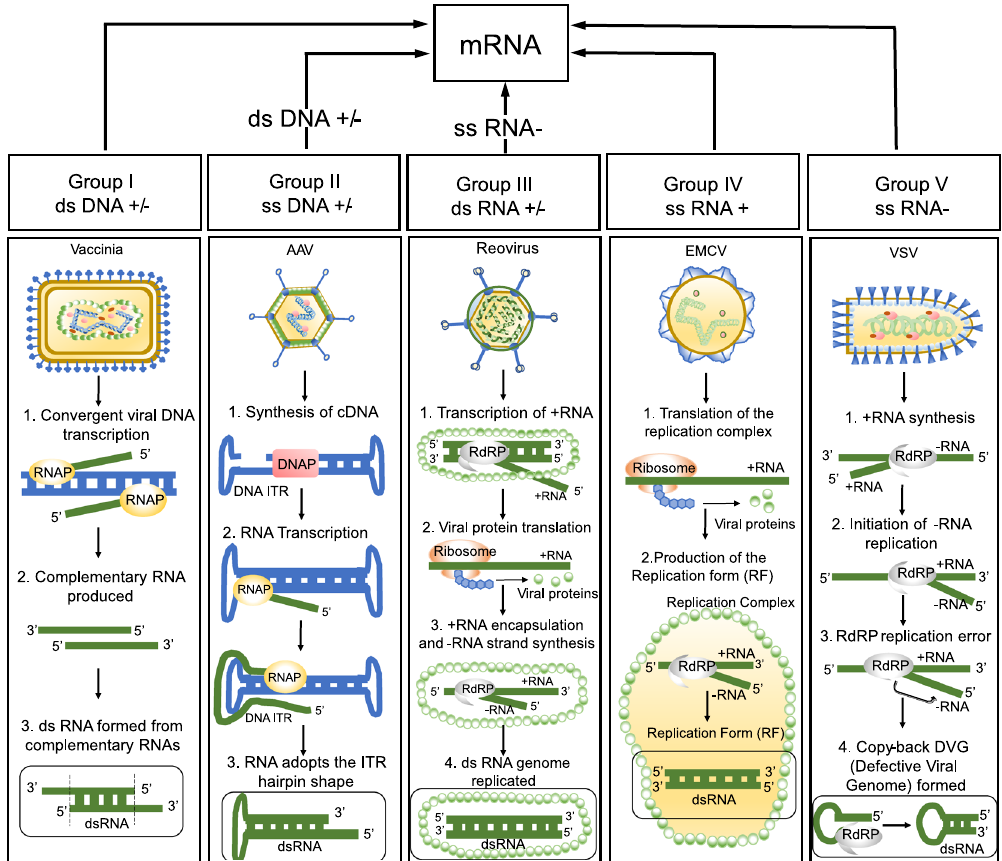
Figure 6. Mechanisms of dsRNA production across representative viruses for each Baltimore classification, excluding retro-viruses. The top part of the diagram depicts the Baltimore-based pathway each viral type uses to produce mRNA, while the bottom shows mechanisms for how each of the representative viruses make dsRNA (circled at the bottom of each panel). DNA is indicated in blue, while RNA is denoted by green